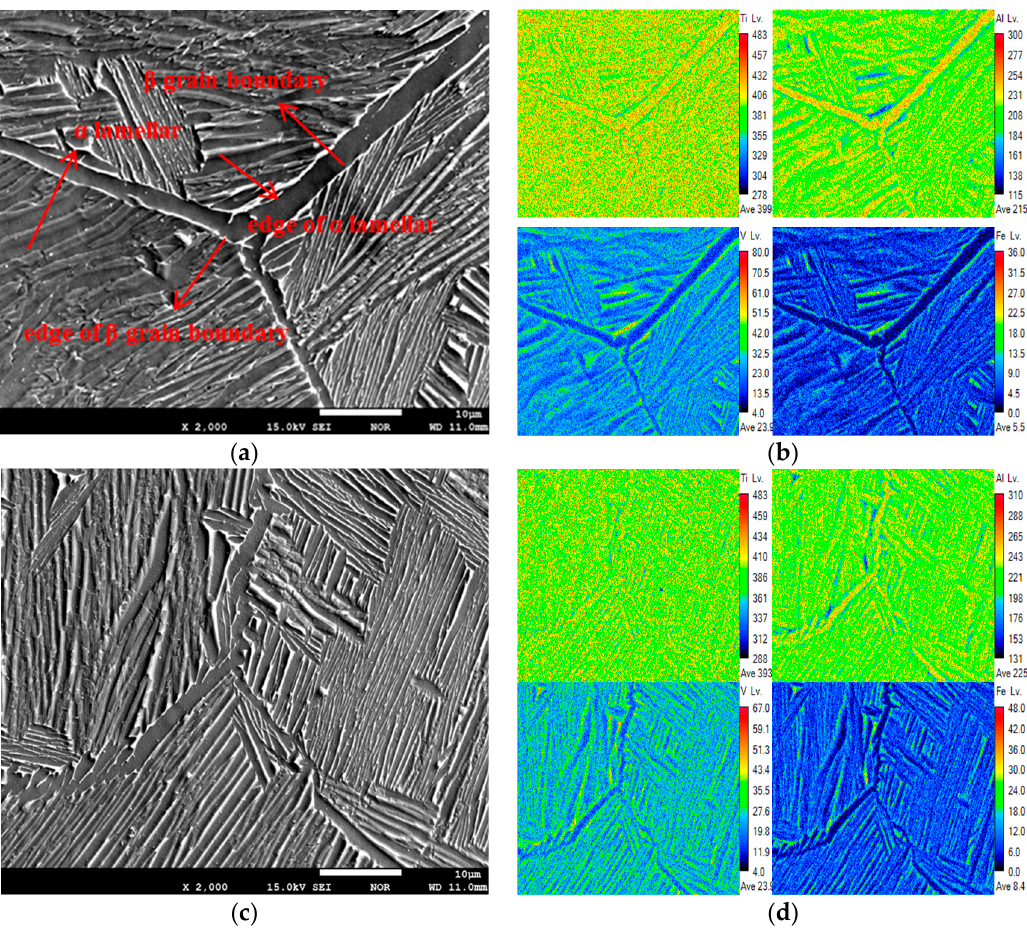
Figure 11. Results of the electron probe micro analysis surface scan. ( a ) Secondary electron image of Ti–6Al–4V–0.5Fe, ( b ) Concentration distribution of Ti–6Al–4V–0.5fe, ( c ) Secondary electron image of